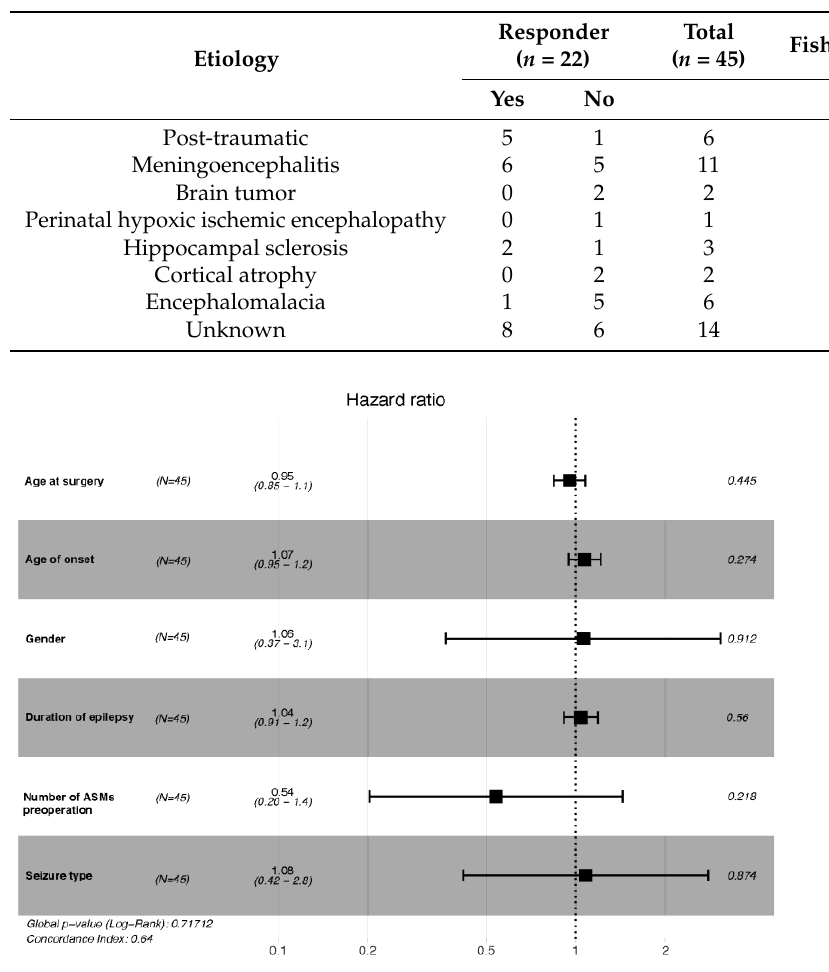
Table 4. Responders according to etiology.